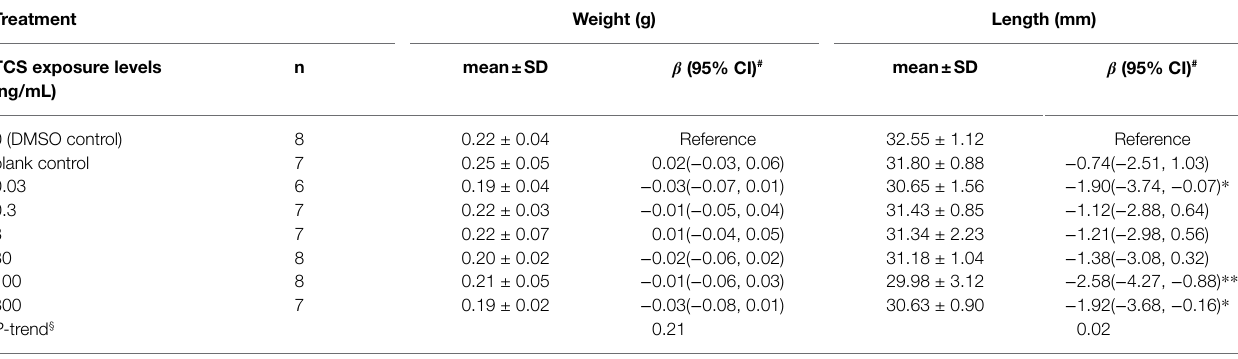
TABLE 3 | The effects of different concentrations of TCS exposure on the weight and length of zebrafish.